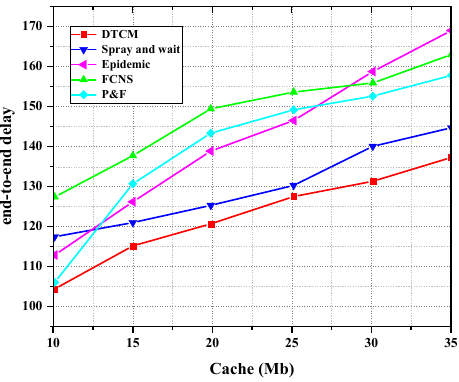
Figure 8. Average end-to-end delay comparison from five algorithms with various cache spaces.